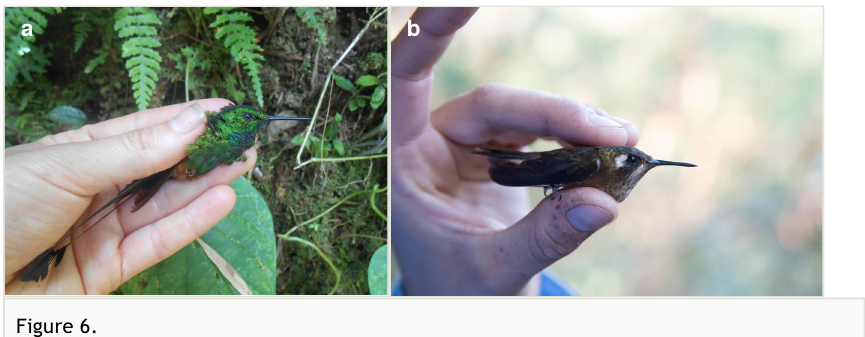
Figure 6. Representative hummingbirds captured near San Pedro (Paucartambo Province, Cuzco Region, 1400 m). Photo "b" taken by Meredith Miles, Wake Forest University.